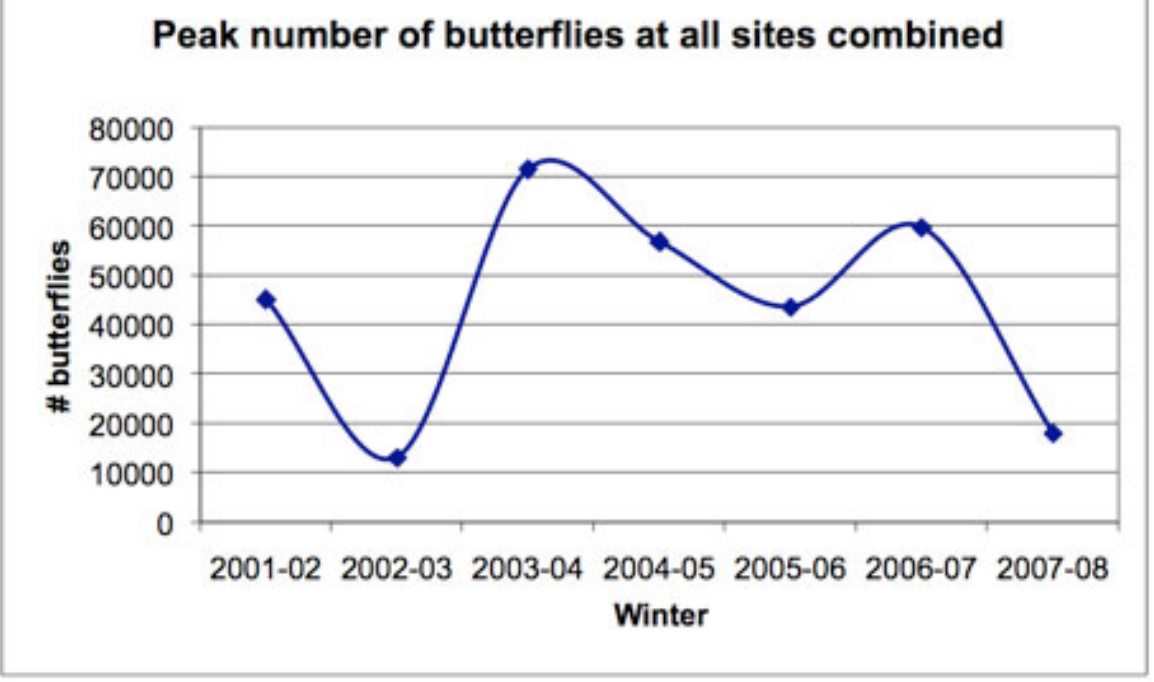
Figure 4. Changes in number of overwintering Monarch butterflies in Monterey County, California summed for all census areas (Ventana Wildlife Society,